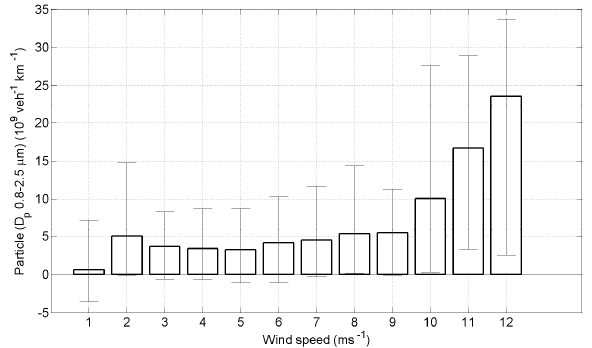
Fig.6: Median number emission factor for particle size (D P = 0.8 – 2.5 µm) within constant wind Fig. 6. Median number emission factor for particle size ( D p = 0 . 8– 2.5µm) within constant wind speed intervals Vertical bars represent speed intervals Vertical bars represent the 25, 75 percentiles. the 25, 75